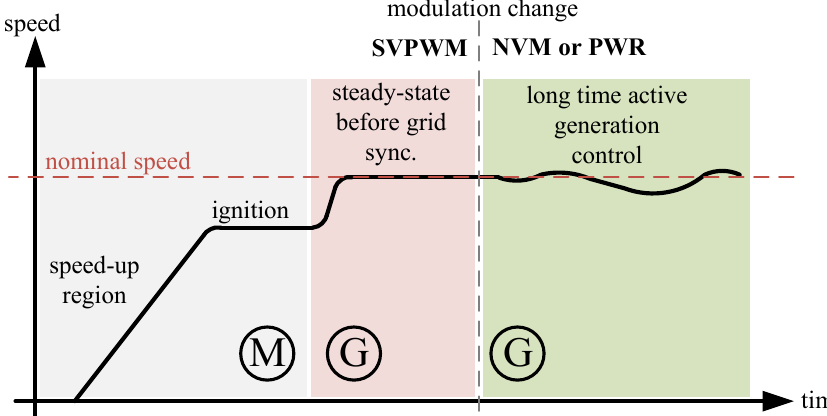
Figure 2. The simplified speed profile of the gas turbine: M—PMSM operates as a motor, G—PMSM operates as a generator, SVPWM—high-frequency modulation method based on the space-vector concept, Nearest Vector Modulation (NVM) and Pulse Width Modulation (PWR)—the low-switching frequency type of PWM